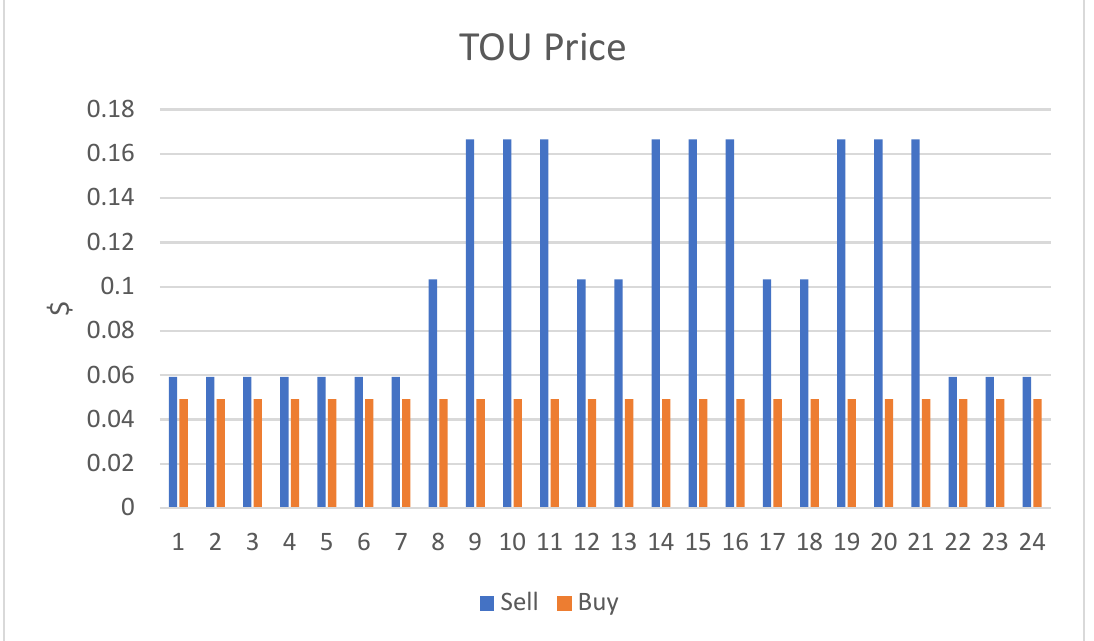
Figure 3. Real-time prices of power buying and selling from the upstream network.